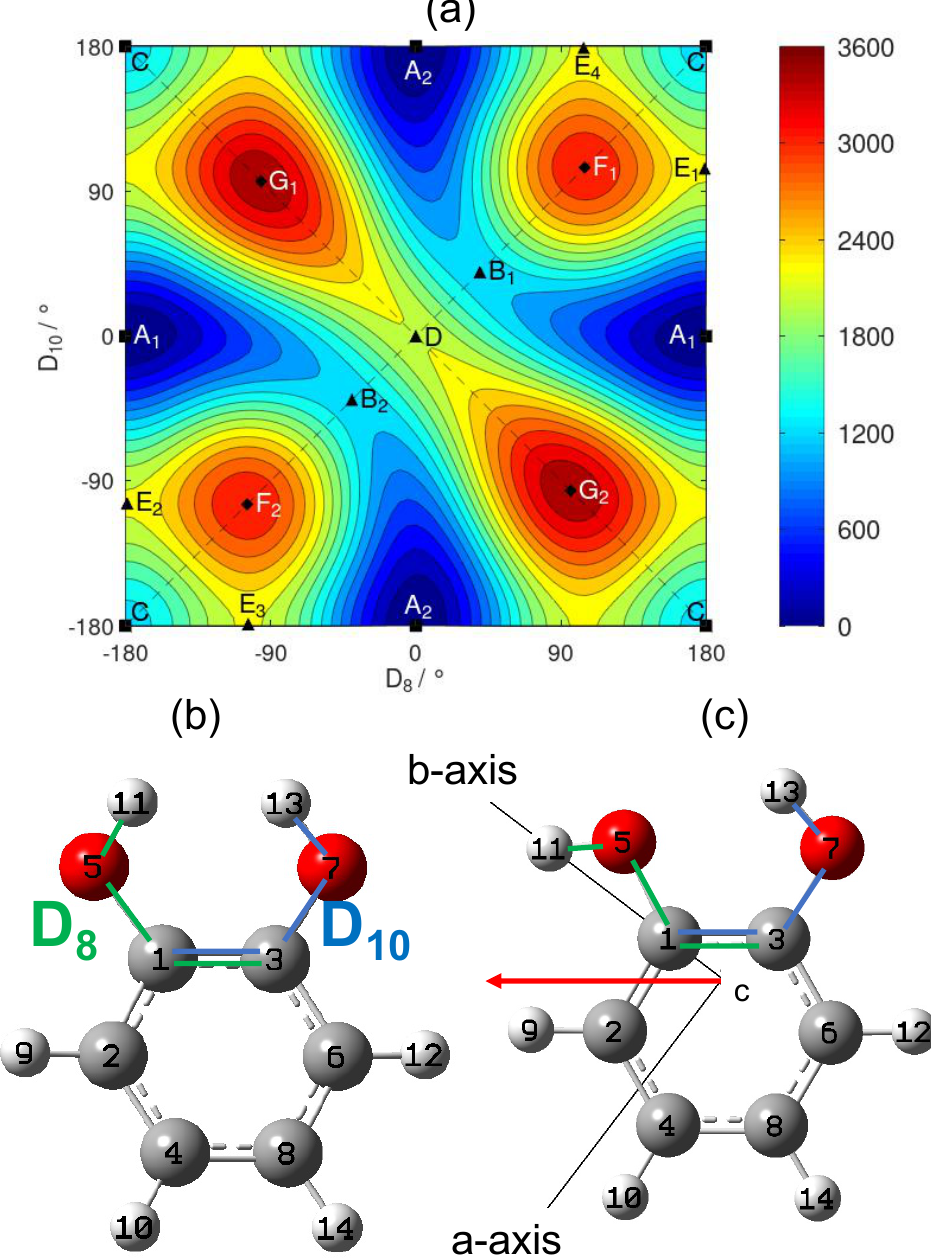
Figure 1. ( a ) 2D scan of the -OH torsional angles of catechol calculated with the B3LYP functional and the aug–cc–pVTZ basis set. The left and upper borders must be respectively identified with the right and lower borders. Contour curves are drawn every 200 cm − 1 . The points A to G correspond to stationary points of the two-dimensional surface, sorted by increasing energy, see Table 2. Symmetry equivalent points share the same letter and are distinguished by a subscript. Squares, triangles, and diamonds, respectively, indicate the minima, saddle points, and maxima. ( b ) Labelling of the nuclei of catechol and definition of the two torsional angles as the dihedral angles D 8 (green sequence of nuclei) and D 10 (blue sequence). This structure corresponds to the saddle point D (central point in the right figure) with D 8 = D ( H ( 11 ) -O ( 5 ) -C ( 1 ) -C ( 3 )) = 0 ◦ and D 10 = D ( H ( 13 ) -O ( 7 ) -C ( 3 ) -C ( 1 )) = 0 ◦ . ( c ) Conformation A 1 corresponding to one of the two global minima. The permanent dipole moment in the ( a , b ) principal inertia plane is indicated by the red